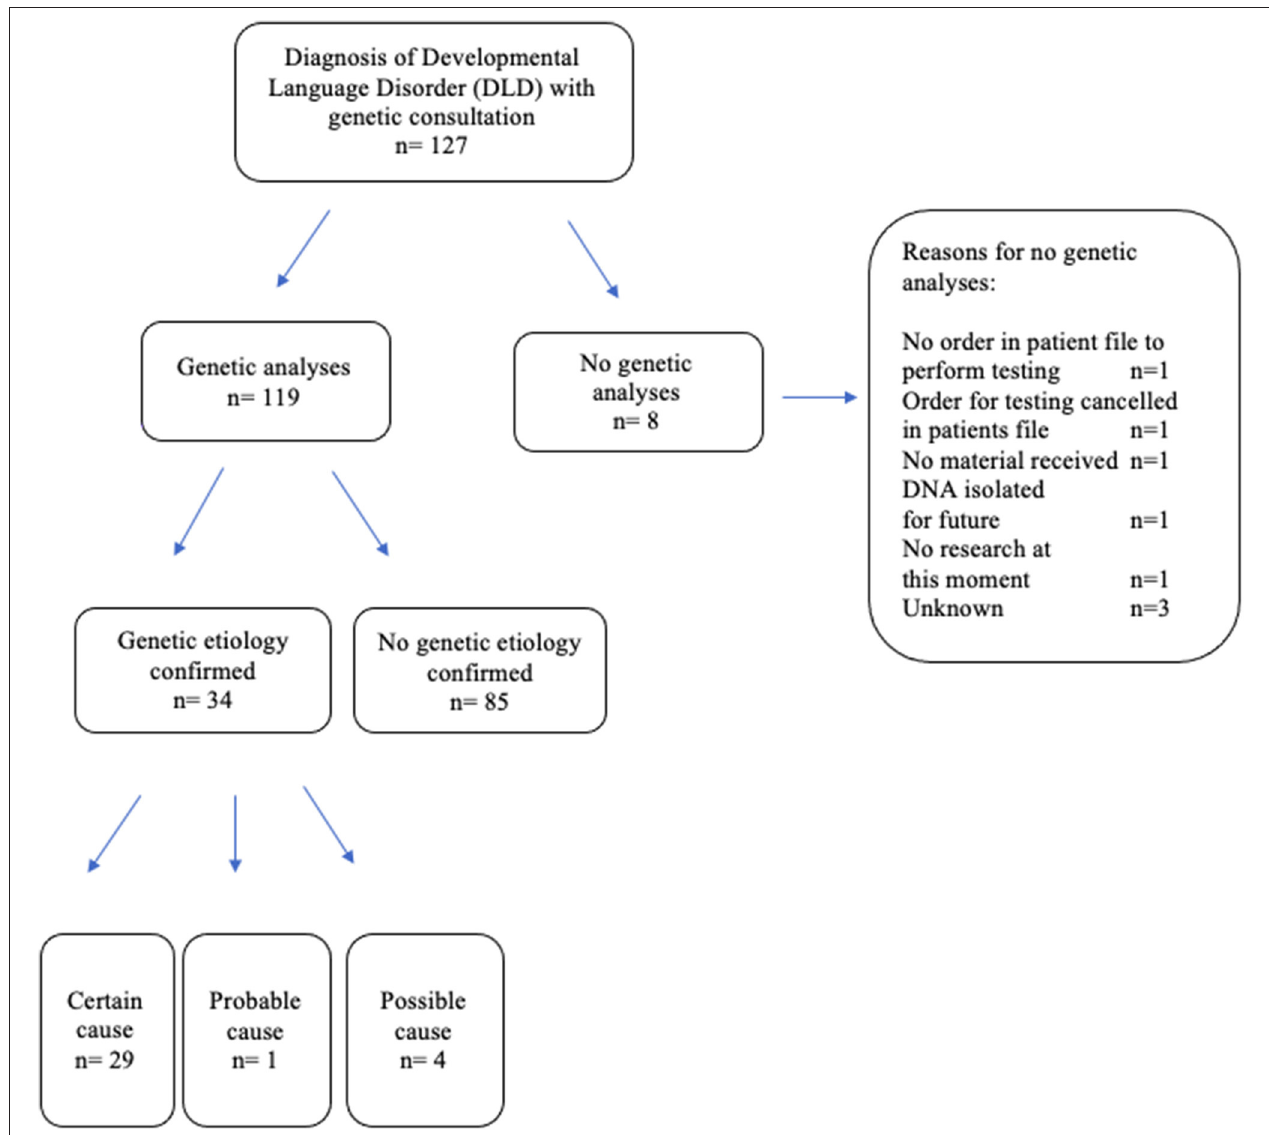
FIGURE 1 | Included study patients with developmental language disorder